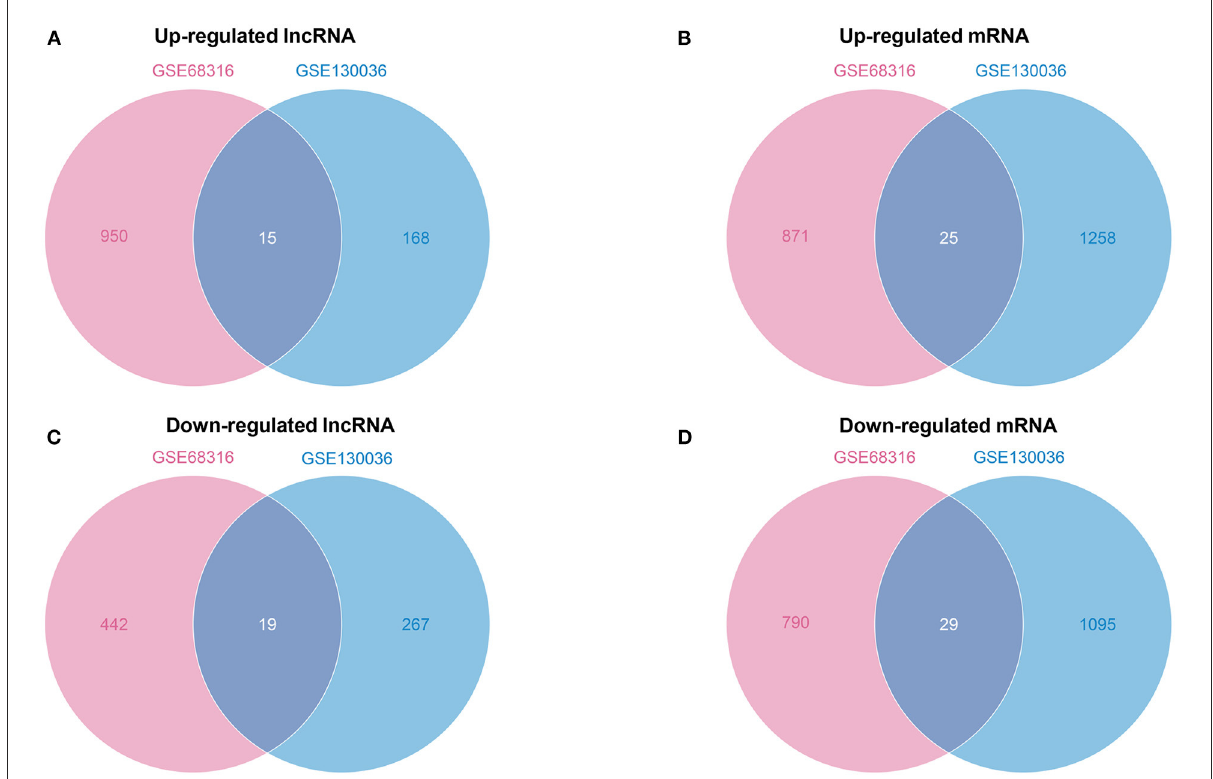
FIGURE3 A Venn diagram of common differentially expressed lncRNAs and mRNAs. (A) A Venn diagram of upregulated common differentially expressed lncRNAs. (B) A Venn diagram of upregulated common differentially expressed mRNAs. (C) A Venn diagram of downregulated common differentially expressed lncRNAs. (D) A Venn diagram of downregulated common differentially expressed mRNAs.